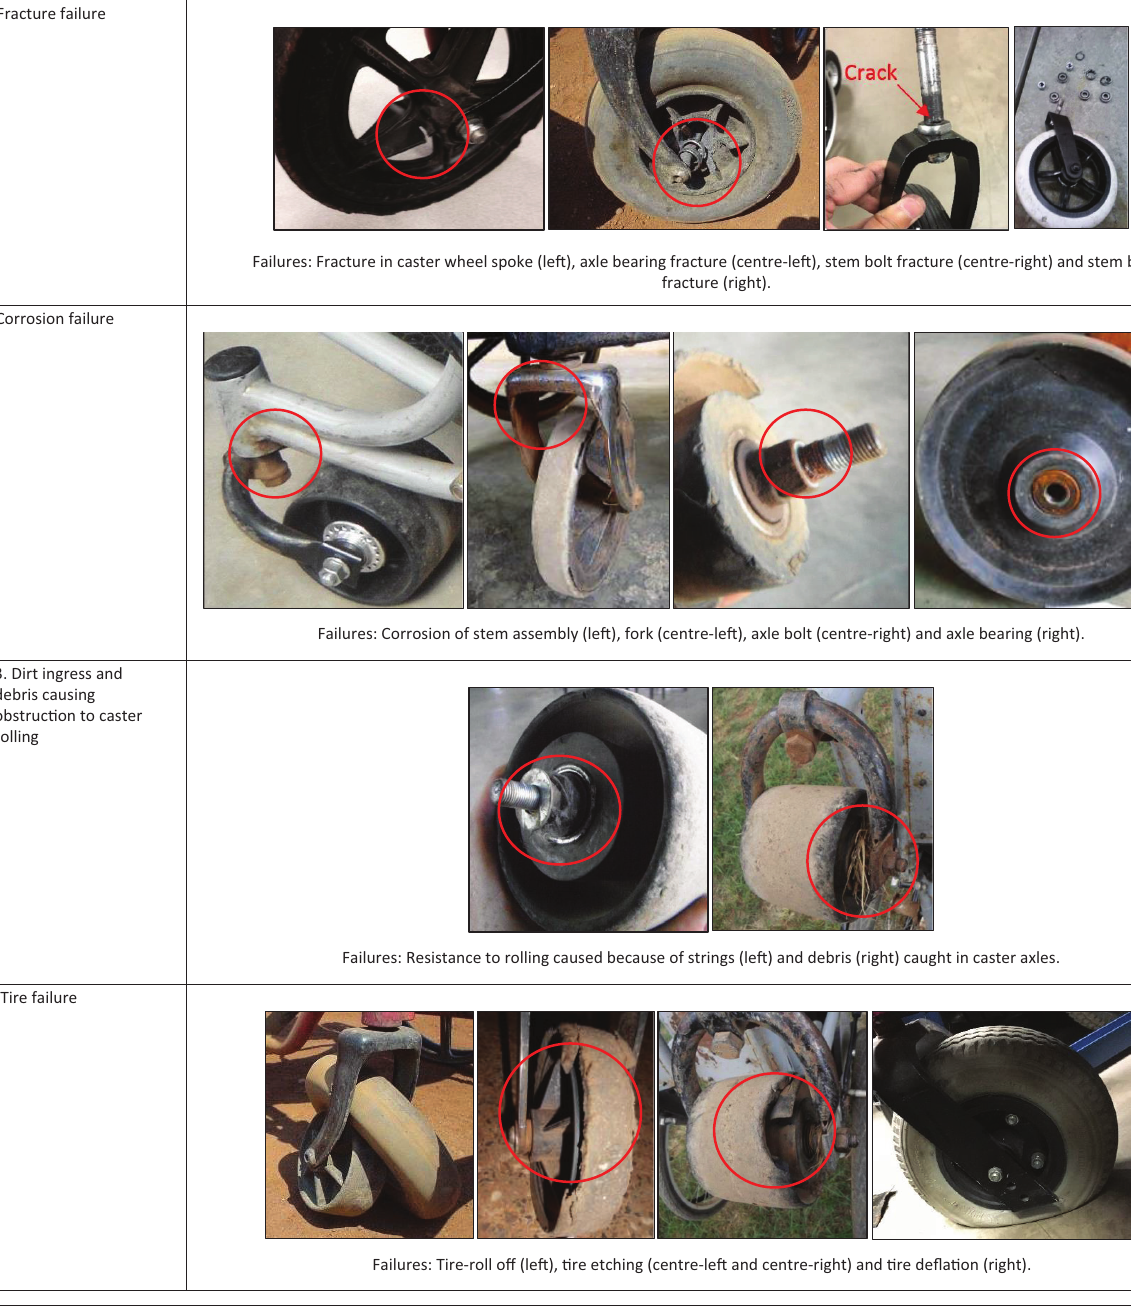
FIGURE 2: Caster assembly failures witnessed in the